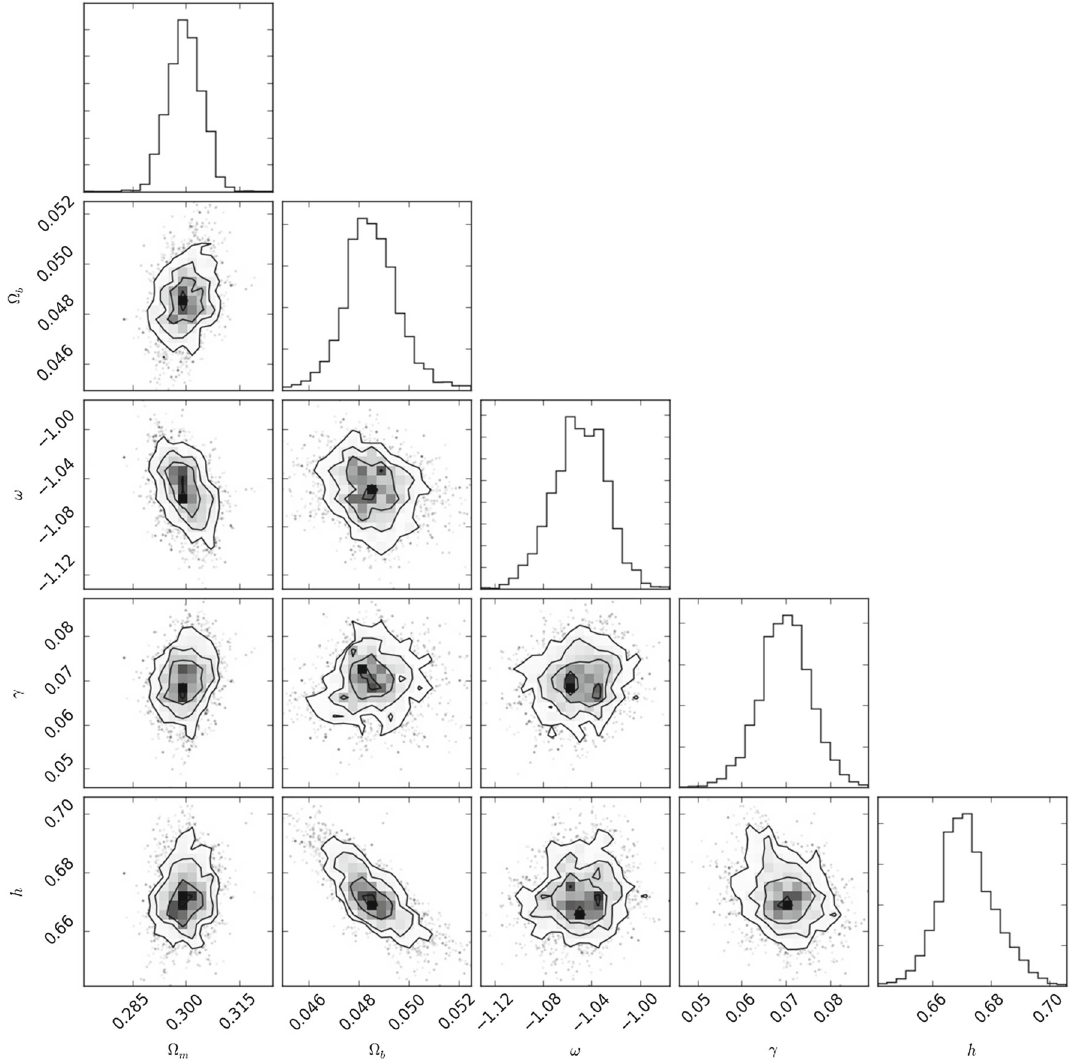
Fig. 1 We display the results for 1 σ , 2 σ and 3 σ for the model (i) in the parameter space ((cid:8) m ,(cid:8) b ,ω,γ, h ) using all the